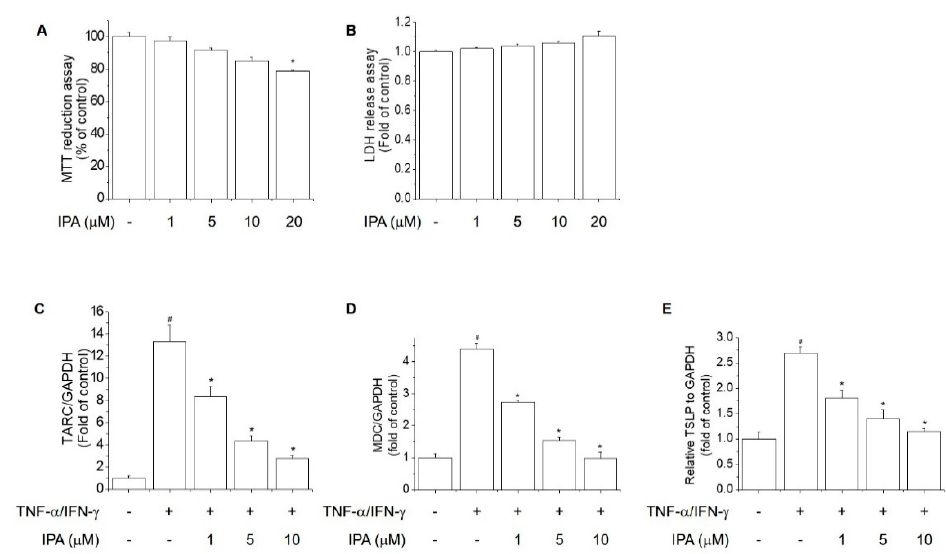
Figure 6. Inhibitory effect of IPA on the mRNA levels of TSLP, TARC, and MDC in TNF- α /IFN- γ - stimulated HaCaT cells. ( A ) Cells were treated with various concentrations of IPA for 24 h. Cell viability was assessed by MTT reduction assay. ( B ) Cell cytotoxicity was determined by LDH release assay. ( C – E ) Cells were treated with IPA (1, 5 or 10 μ M) for 1 h, and then stimulated with TNF- α /IFN- γ (each 10 ng/mL) for 6 h, and the mRNA levels of TSLP, TARC, and MDC were determined by real-time PCR. Results are means ± SD (n = 3). # p < 0.01, versus the control group. * p < 0.01, versus the TNF- α /IFN- γ -treated group.